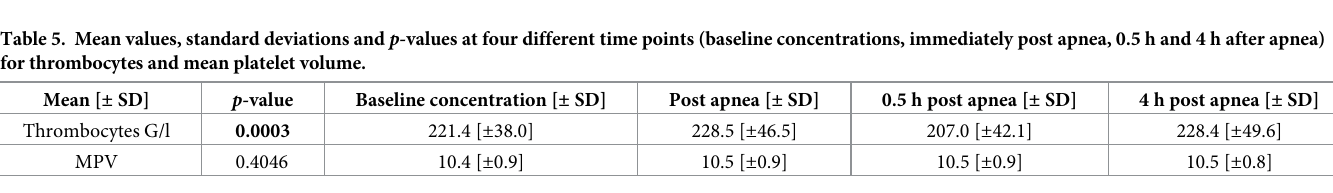
Table 6. Differences between three time intervals versus baseline concentrations for thrombocytes and mean platelet volume. Thrombocyte p -value Post apnea vs. baseline parameter concentration (mean value [CI]) Thrombocytes G/l